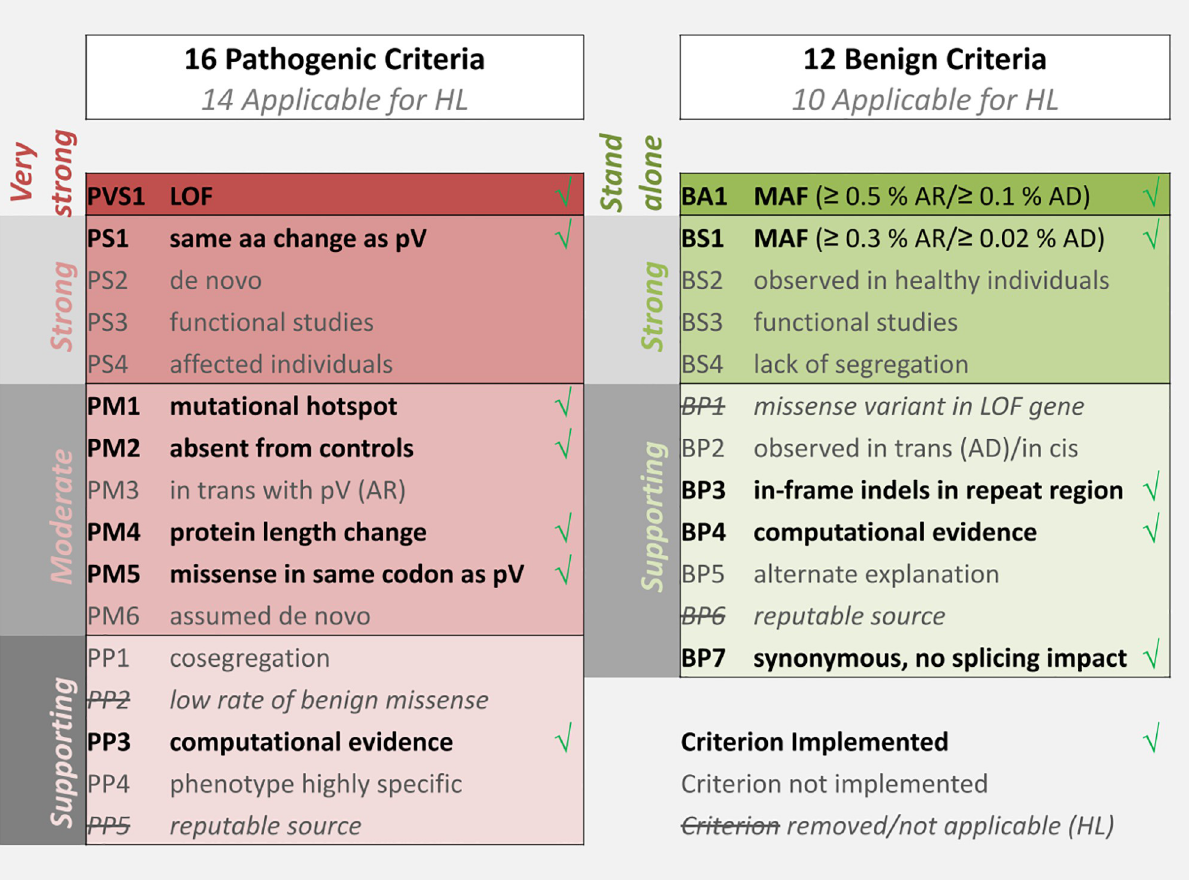
Fig 1. Overview of ACMG/AMP evidence-based criteria. Green marks show implemented criteria. Grey font shows not implemented criteria. Striked-through shows removed or not applicable criterion for hearing loss. Thresholds shown for BA1 and BS1 are specific for HL.